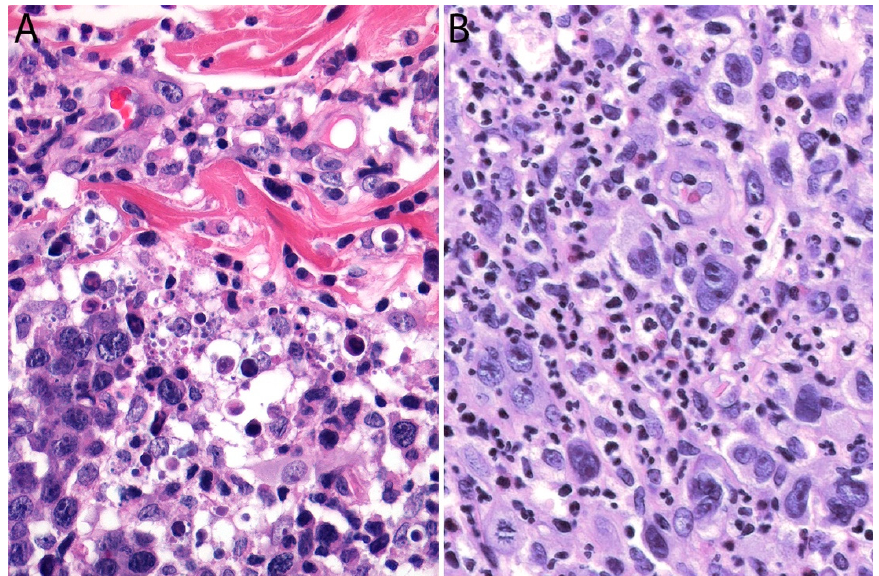
Figure 14. ( A ) Primary cutaneous ALCL with pleomorphic/anaplastic cells with numerous apop- totic bodies. ( B ) Extensive neutrophilic infiltrate in a case of “neutrophil-rich” pc-ALCL (“pyogenic cutaneous